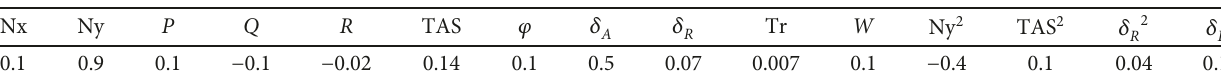
(c) Correlation between selected regressors and β